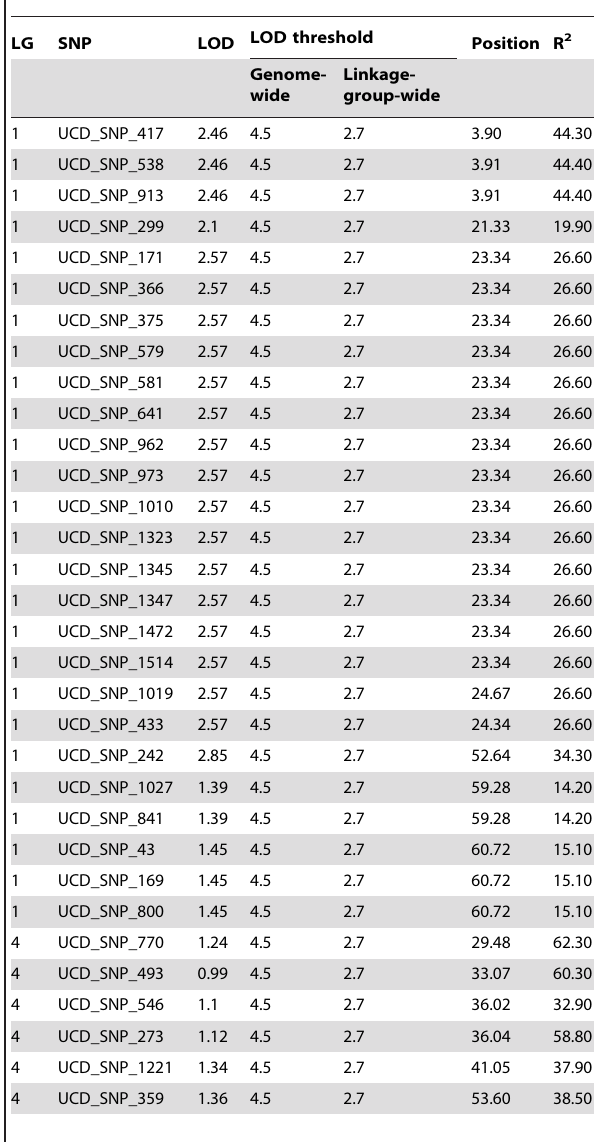
Table 1. Identification of QTLs controlling brown rot resistance with three years of data in the F1 population from ‘Dr. Davis’ x